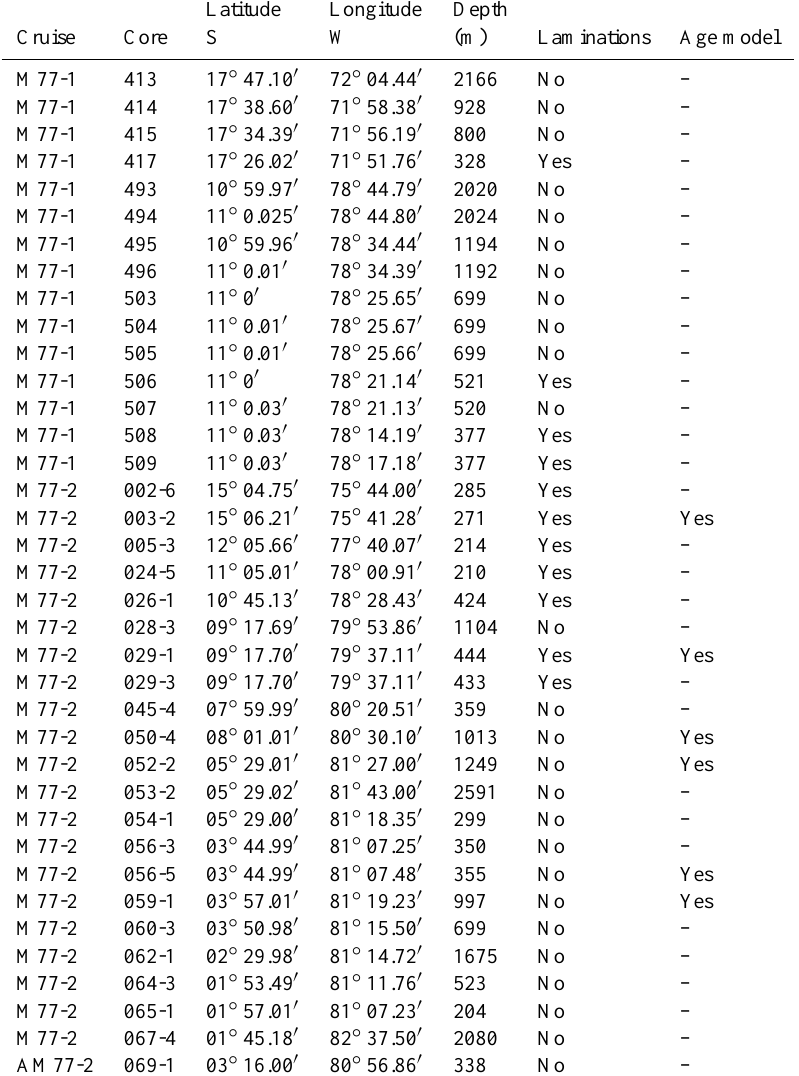
Table A1. Metadata of cores for which information about laminations were available. ∗ Last Glacial to 12ka; ∗∗ chronostratigraphy based on δ 18 O curve; ∗∗∗ chronostratigraphy based on correlation with cores from IODP hole 680A; –: no information